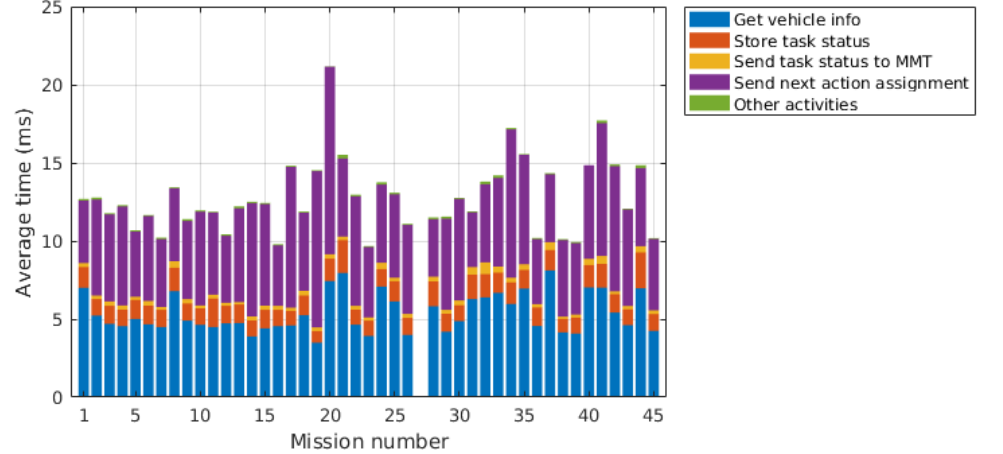
Figure 32. Average time distribution for processing the task status reports.